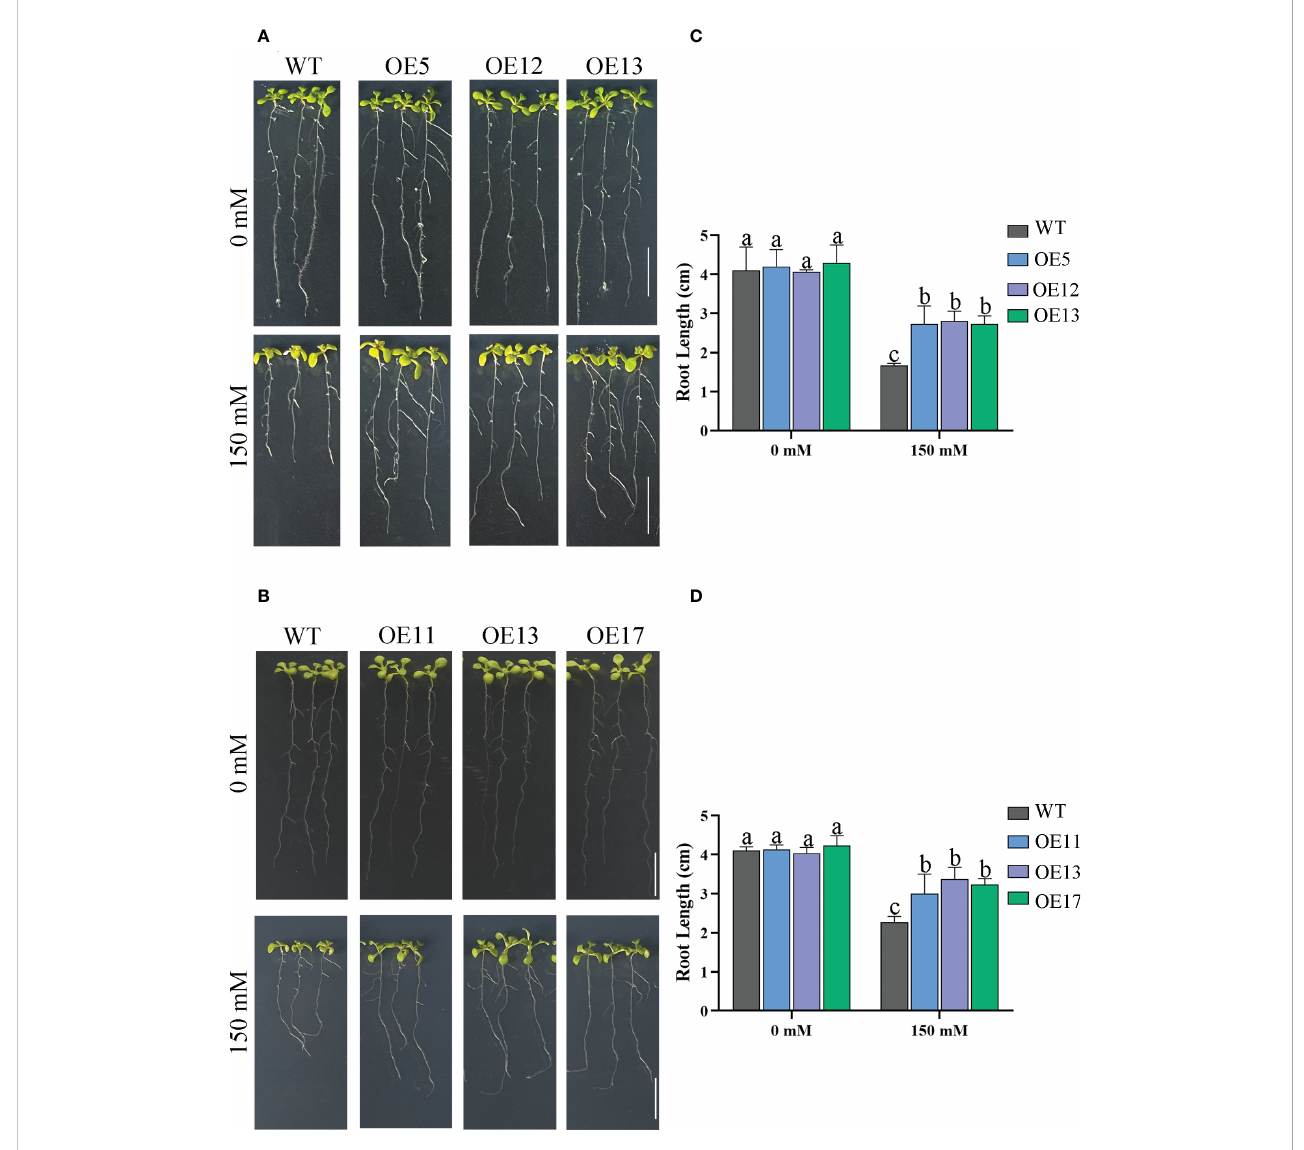
FIGURE 7 Primary root length of plants grown on media under salt treatment. (A) The root length of CeqHAK6 -OE lines and WT plants under salt stress. (B) The root length of CeqHAK11 -OE lines and WT plants under salt stress. Each seedling planted to 1/2 MS media containing 0 and 150 mM NaCl. Scale bar = 1 cm. (C) Calculation of the root length of CeqHAK6 transgenic and WT plants. (D) Calculation of the root length of CeqHAK11 transgenic and WT plants. The signi fi cant differences identi fi ed using Duncan ’ s Multiple Range Test ( p <0.05) were denoted by different lowercase letters on the top of